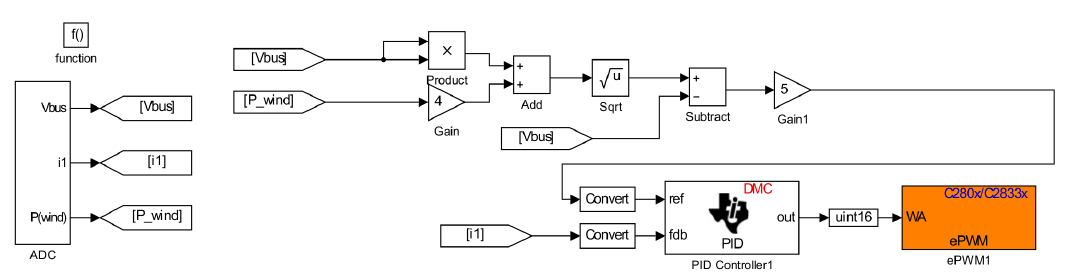
Figure 7. HIL controller for Source 1: optimal multidimensional droop.